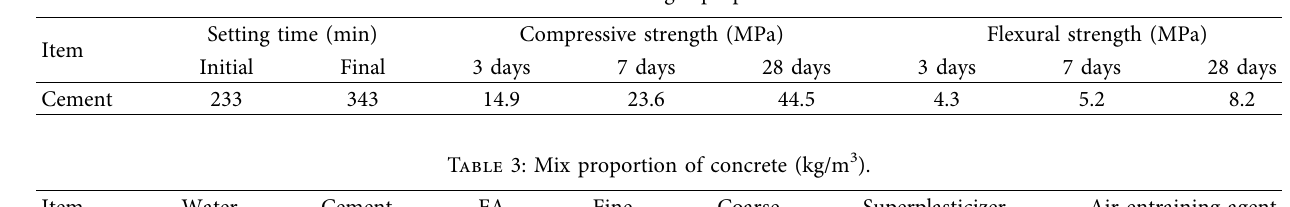
Table 2: Mechanical strength properties of cement.